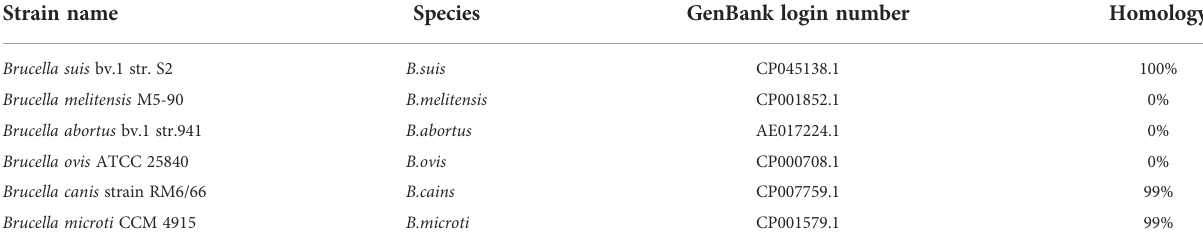
TABLE 4 BLAST analysis of the GL_0002189